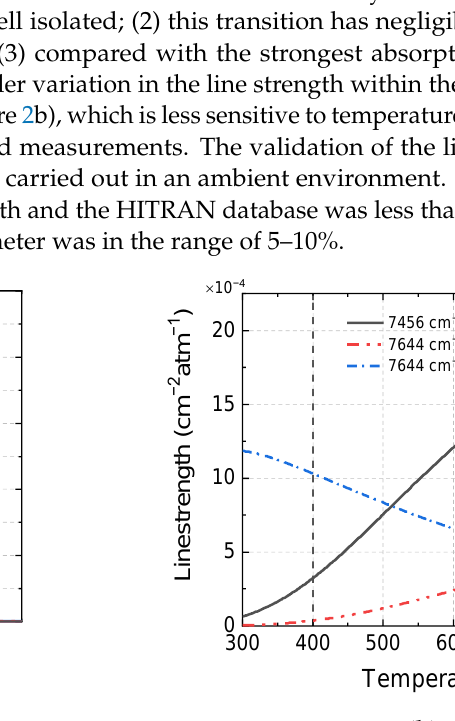
(1) 7644.6 cm − 1 is well isolated; (2) this transition has negligible interference from other